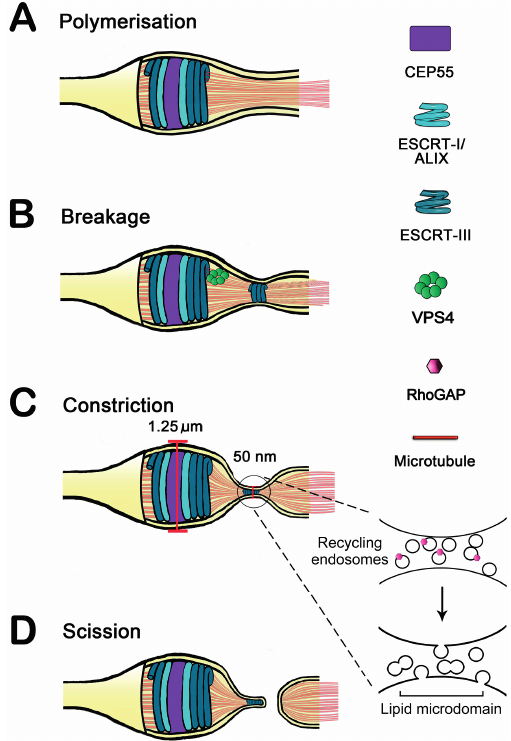
Figure 1. Schematic model for abscission in mammalian cells. In panel ( A ),